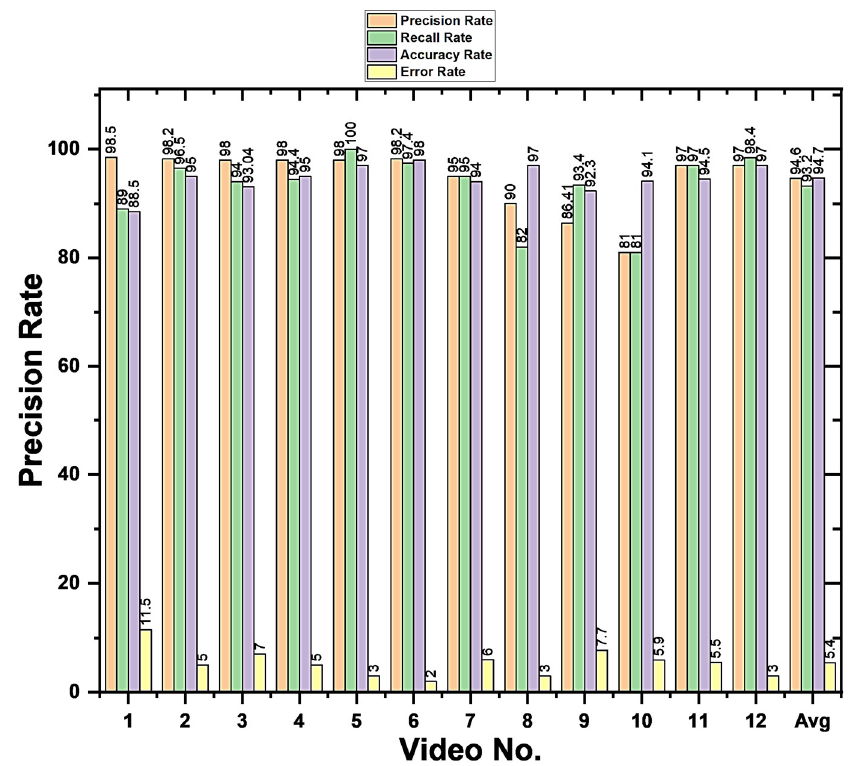
Figure 10. Visual representation of the performance of our proposed model.